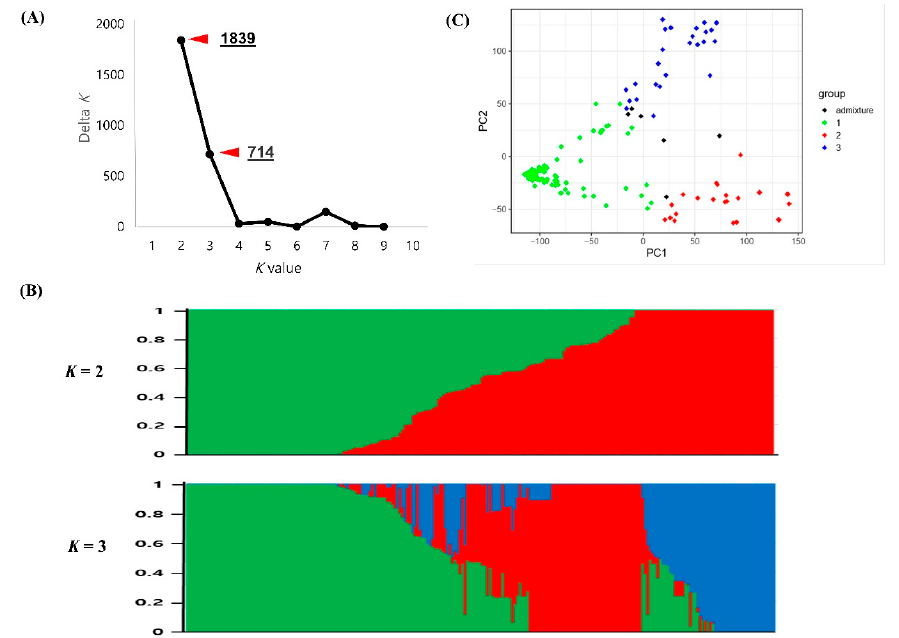
Figure 4. Population structure and principal component analysis (PCA) of the Korean cowpea accessions. ( A ) Delta K ( Δ K ) plot calculated from K = 2 to K = 9. ( B ) Population structure classification of the 229 Korean cowpea accessions using membership probability (Q-values). Each box plot within the different colored segments represents a different population. ( C ) PCA scatter plot of the 229 accessions along the PC1 and PC2 axes. The colors of the scatter plot are the same as those in the structure box plot.